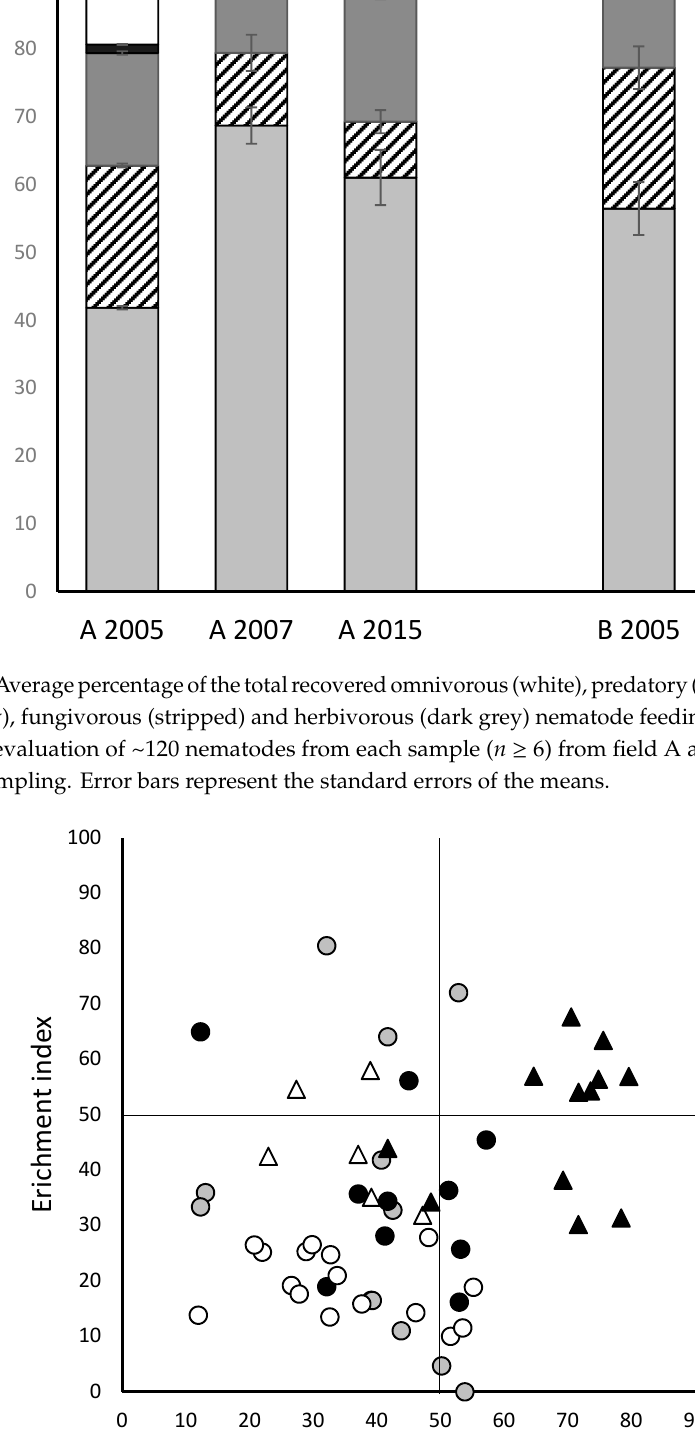
), Figure 3. Food web analysis of nematode community assemblages from field A, sampled in 2005 ( ○ ), (cid:35)